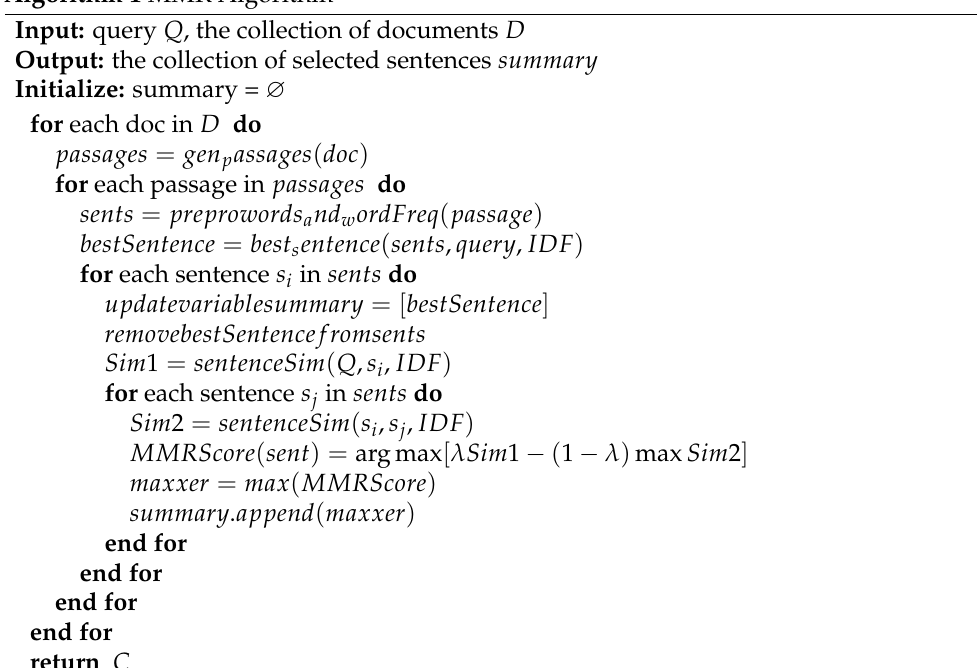
Algorithm 1 MMR